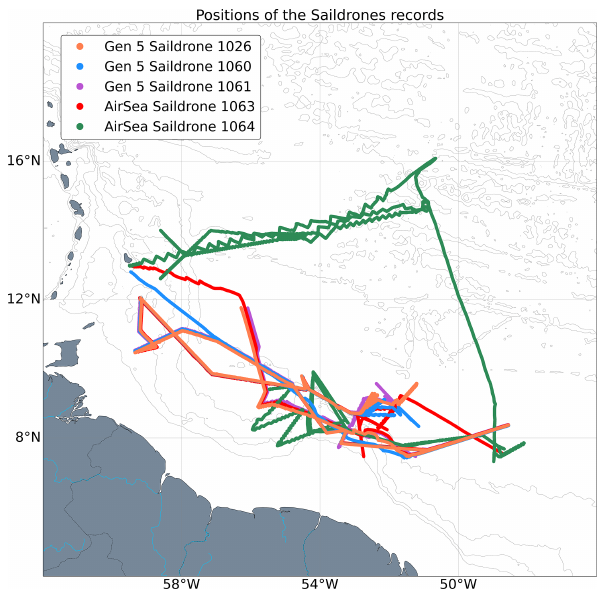
Figure 16. Map of the five Saildrone positions. Three NASA Sail- drones (1026, 1060, and 1061) and one NOAA Saildrone (1063) have followed R/Vs Maria S. Merian and L’Atalante tracks to sam- ple surface mesoscale eddies, while one NOAA Saildrone (1064) has first sampled the trade wind